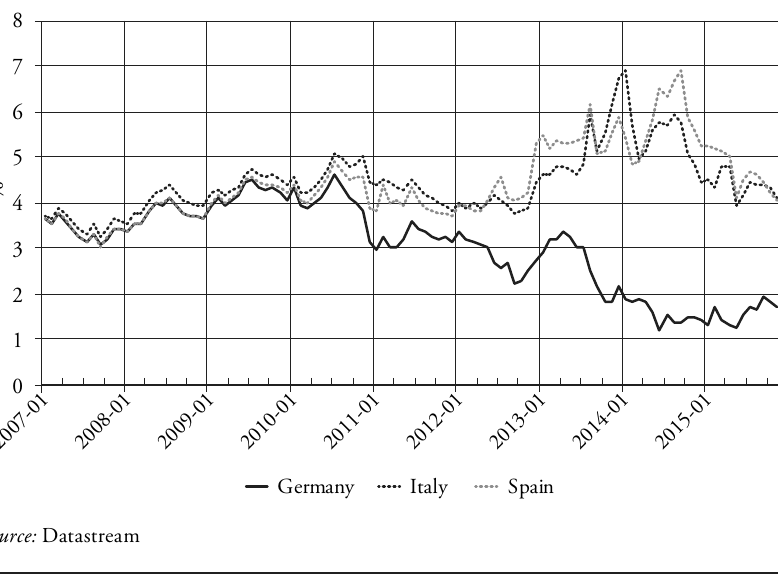
Figure 2: Sovereign Bond